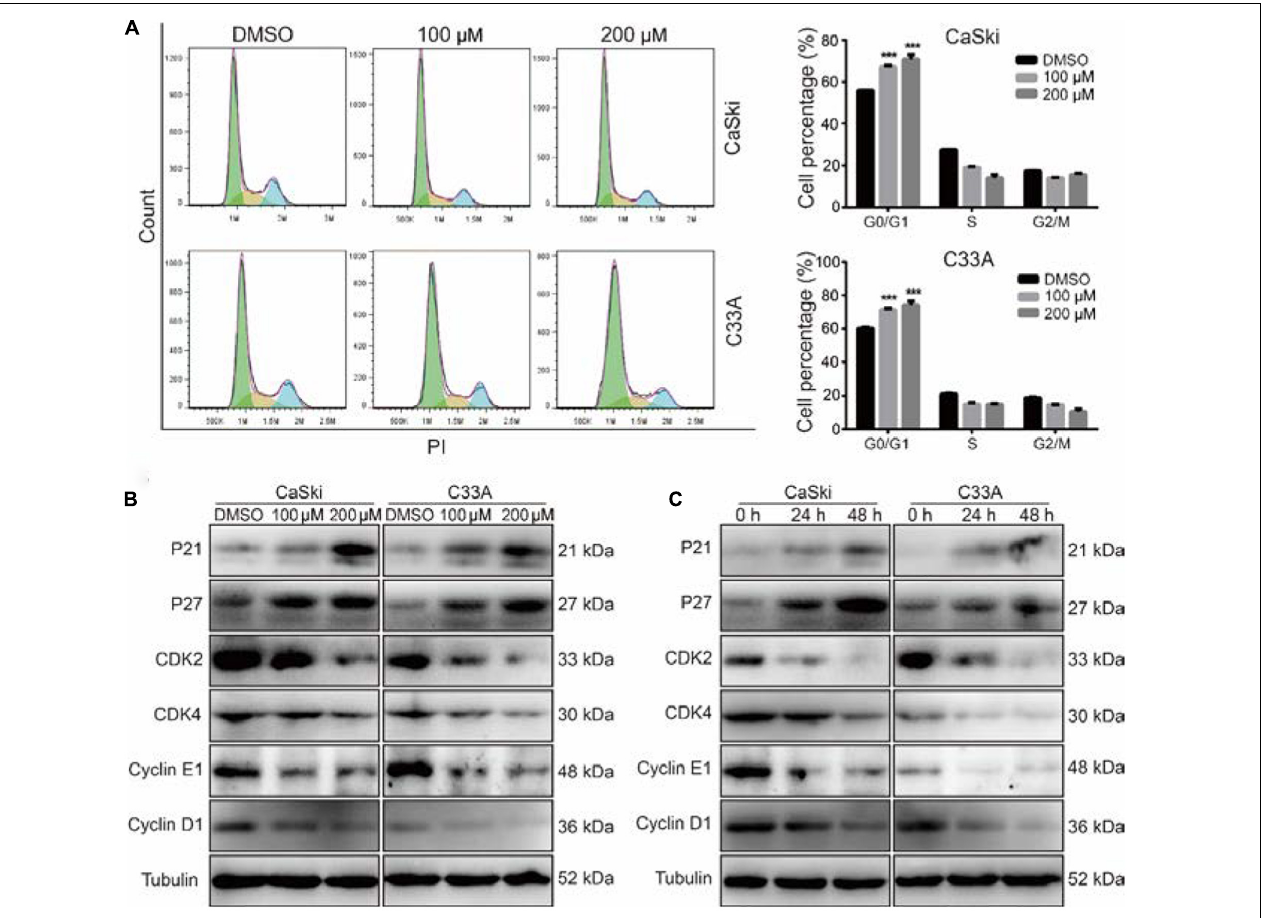
FIGURE 2 | Polydatin inhibits cell growth by inducing cell cycle arrest at the G1/G0 phase. (A) Cell cycle analyses were performed using flow cytometry in CaSki and C33A cervical cancer cells after treating with dimethyl sulfoxide (DMSO) or polydatin at the indicated concentration for 48 h. The histogram demonstrates the quantification of the number of cells in different periods. (B,C) Western blot analysis of the cell cycle-related protein levels in CaSki and C33A cells. Cells were treated with polydatin at indicated concentrations or at indicated time. Tubulin was used as a control. All data were analyzed using two-tailed Student’s tests. Error bars, ∗ P < 0.05, ∗∗ P < 0.01, and ∗∗∗ P <